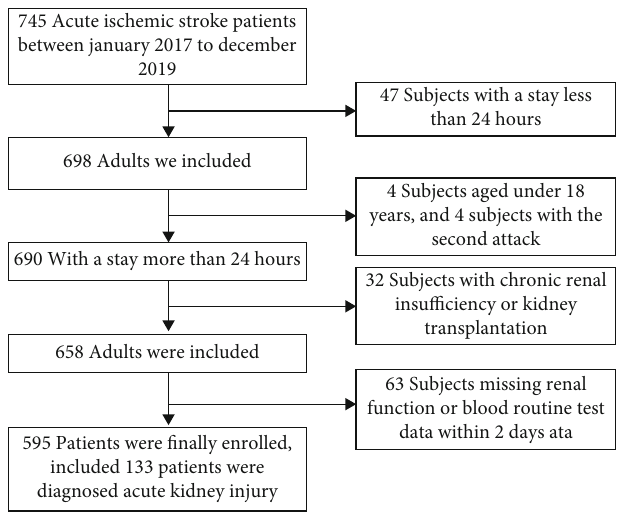
Figure 1: Flowchart of participant